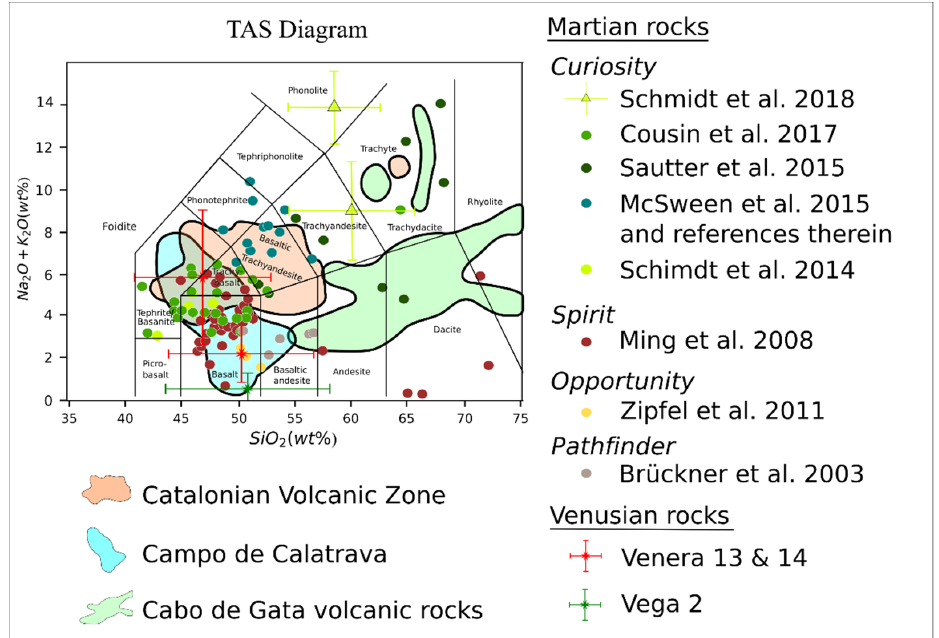
Figure 21. TAS diagram [58] showing the compositional ranges of Catalonian Volcanic Zone, Campo de Calatrava [60] and Cabo de Gata [61], together with in situ analysis of rocks on Mars [36–42,99] and Venus [51].